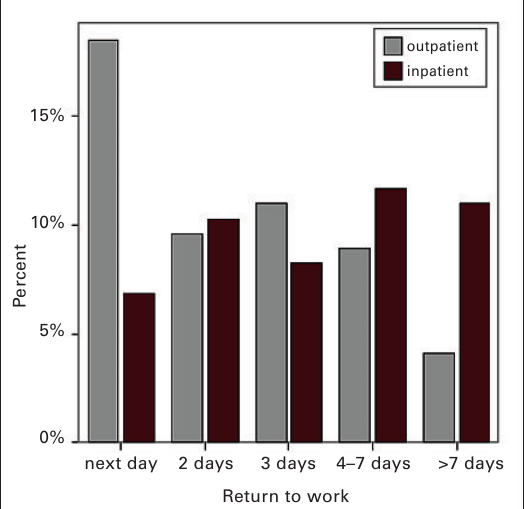
Time to resumption of work or regular everyday activities of patients undergoing radiofrequency catheter ablation in an outpatient (grey bars) or inpatient (black bars)